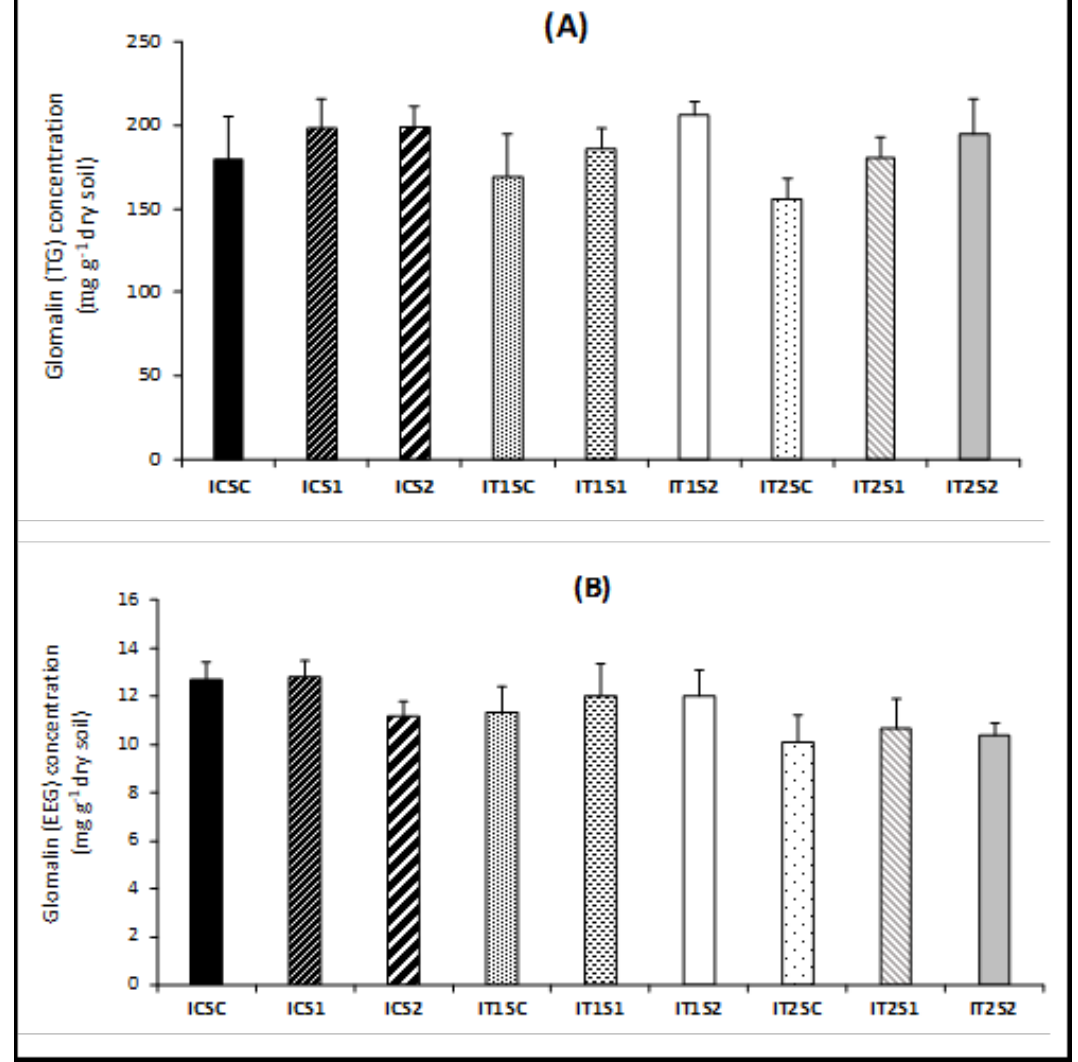
Figure 7. Average values of ( A ) total glomalin-related soil protein (TG) and ( B ) easily extractable glomalin-related soil protein (EEG) mg g − 1 of dry soil for all nine treatments (inoculation type × salinity level) during snap bean production. Treatments consist of inoculation type (IC = No inoculation, IT1 = Mycorrhizal, IT2 = AMF + Rhizobium ) and salinity levels (SC = Salinity control 0.6 dS m − 1 EC, S1 = 1.0 dS m − 1 EC, and S2 = 2.0 dS m − 1 EC). The graph is expressed as mean + standard deviation error bars. Each treatment consisted of n = 5.